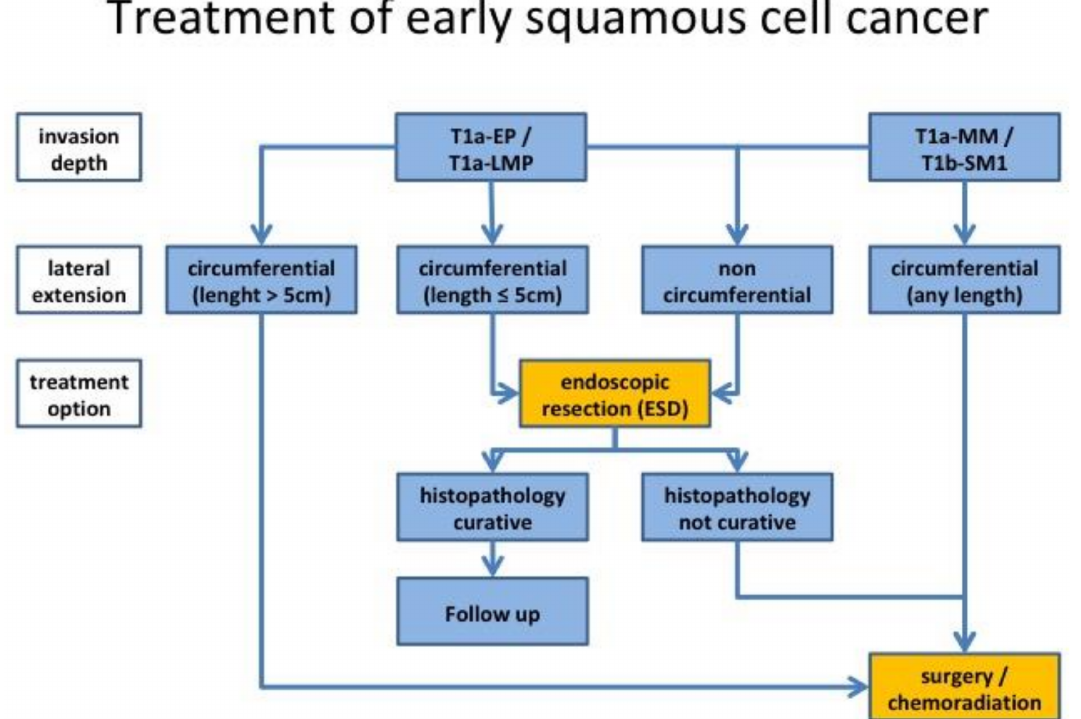
Figure 6. Proposed treatment algorithm of early esophageal squamous cell cancer according to current Japanese guide- lines [21]. Evaluation should include endoscopic ultrasound to assess possible lymph node metastasis in selected cases. Invasion depth is diagnosed according to the Japan Esophageal Society (JES) classification (Table 3). Lateral extension is usually visualized by chromoendoscopy with Lugol’s solution. Criteria for curative resection are listed in Table 4. ESD, endoscopic submucosal dissection; EP, epithelial layer; LMP, lamina propria mucosae; MM, muscularis